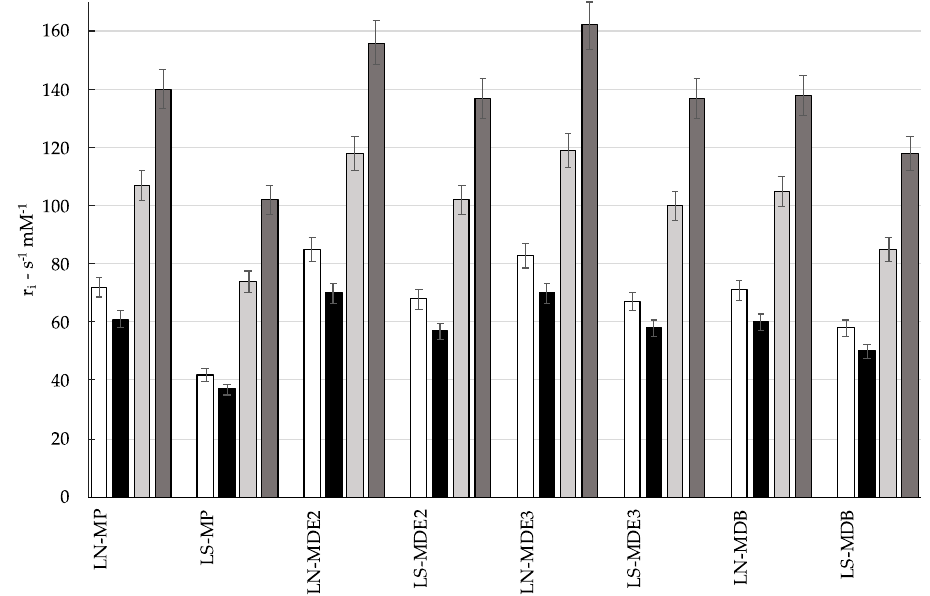
Figure 8. Longitudinal (r 1 ; white, black) and transverse (r 2 ; light gray, dark gray) relaxivity values of the indicated liposomes formulation measured at 25 °C in two magnetic fields: 0.47 T (Larmor frequency 20 MHz, white and light gray) and 1.4 T (Larmor frequency 60 MHz, black and dark gray).